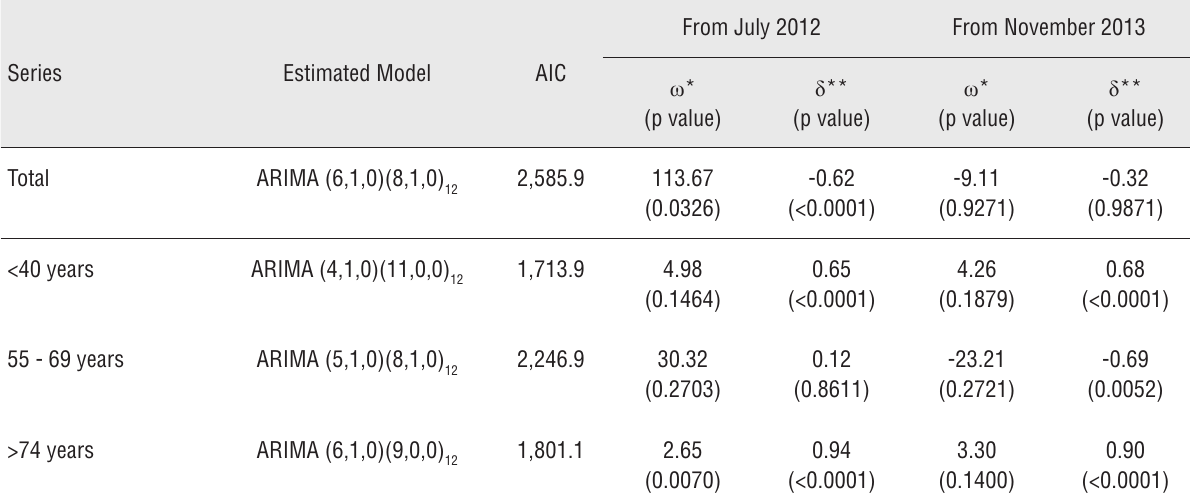
Table 3 - Analysis of the impact of the USPSTF (2012) and INCA (2013)